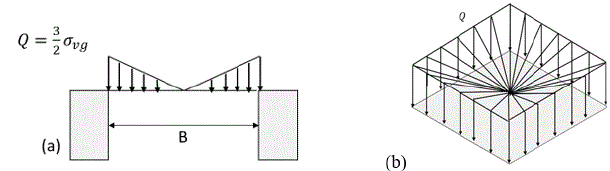
Figure 5. RG stress distribution above the cavity (a) 2D represen- tation on the central geosynthetic strip and (b) 3D representation.